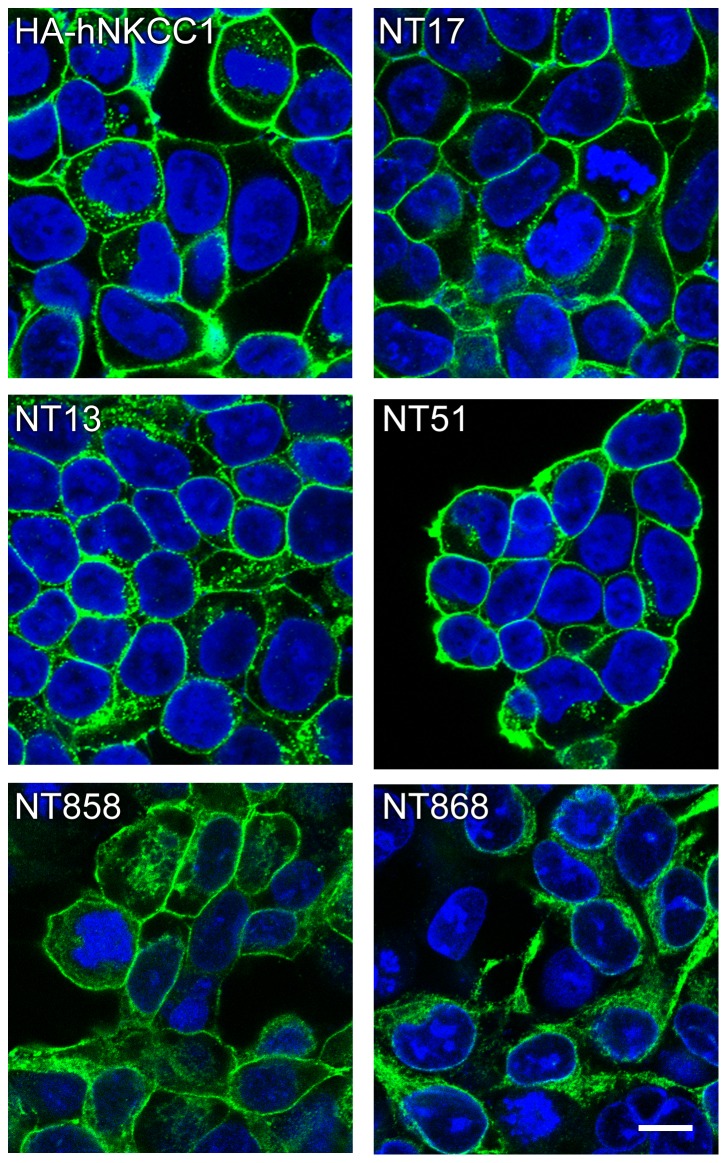
Confocal immunofluorescence images of NKCC1 cell lines.After fixation, NKCC1 is visualized using anti-HA-antibody (HA-hNKCC1) or anti FLAG-antbody (green, Alexa 488 secondary). Nuclei are stained with TO-PRO-3-iodide (Life Technologies). Shown are HA-tagged hNKCC1 [9], 3xFlag-YFP-tagged hNKCC1 (NT17), 3xFlag-Y’FP-tagged hNKCC1 (NT13), NT17 with threonines and serines mutated in the N-terminus phosphoregulatory domain (NT51), TM and intracellular cysless NKCC1 (NT858), and cysless NKCC1 (NT868). The marker in the lower right corner is 10 µm.